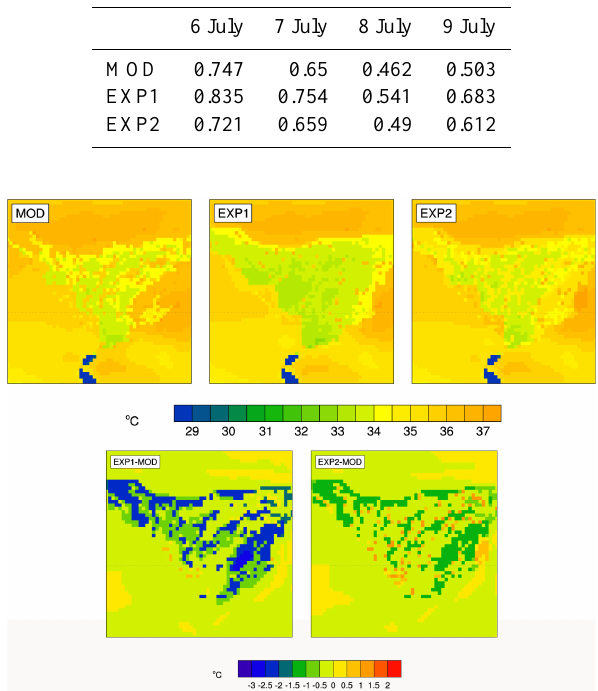
Fig. 8. Air temperature at 2m above ground and its differences be- tween the MOD and the EXP1 and EXP2 simulations at 13:00BT, 6 July 2004.